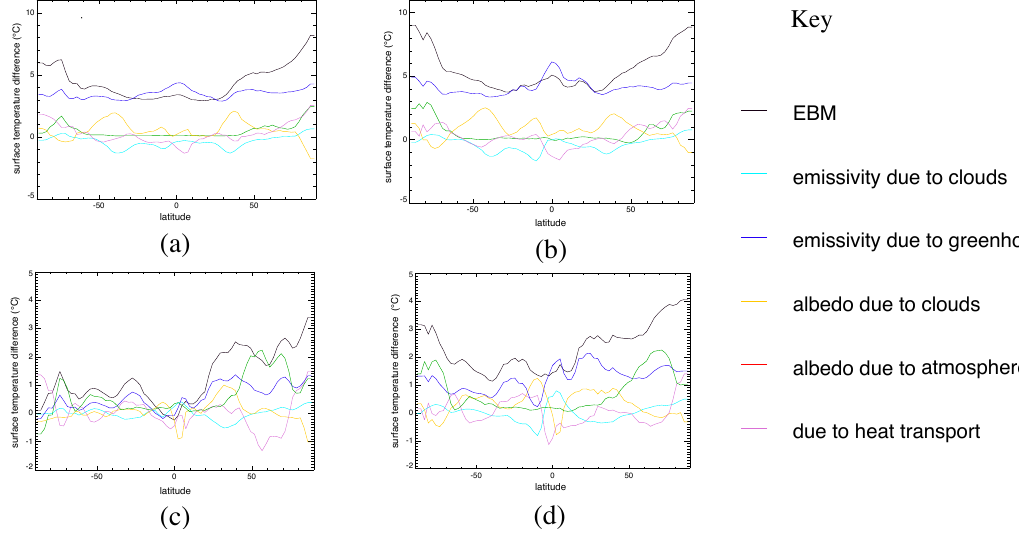
Fig. 17. Contributions from different factors to the annual mean temperature differences when CO 2 in doubled, determined through energy balance model analysis for (a) shrubs everywhere and (b) TRIFFID turned on, and when land surface coverage changes from shrubs ev- erywhere to the vegetation distribution predicted by TRIFFID determined through energy balance model analysis at (c) 2 × and (d) 4 × PI CO 2